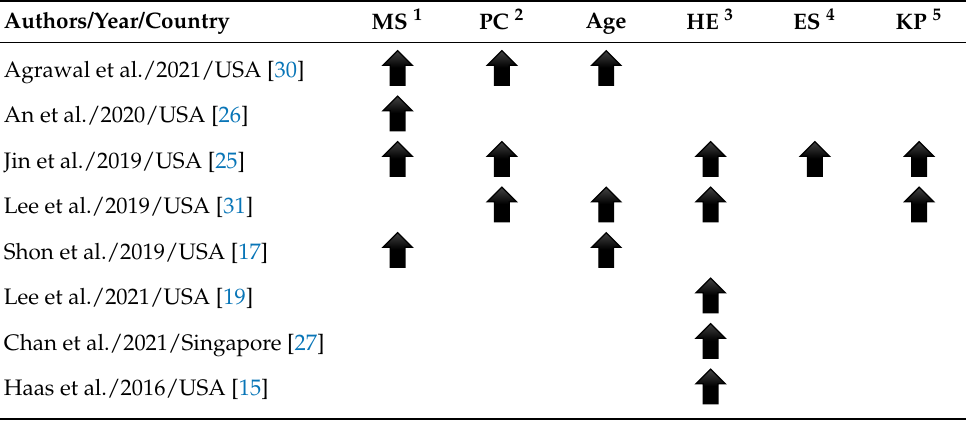
Table 4. Adherence to breast cancer–screening program according to information, confidence and involvement in health.